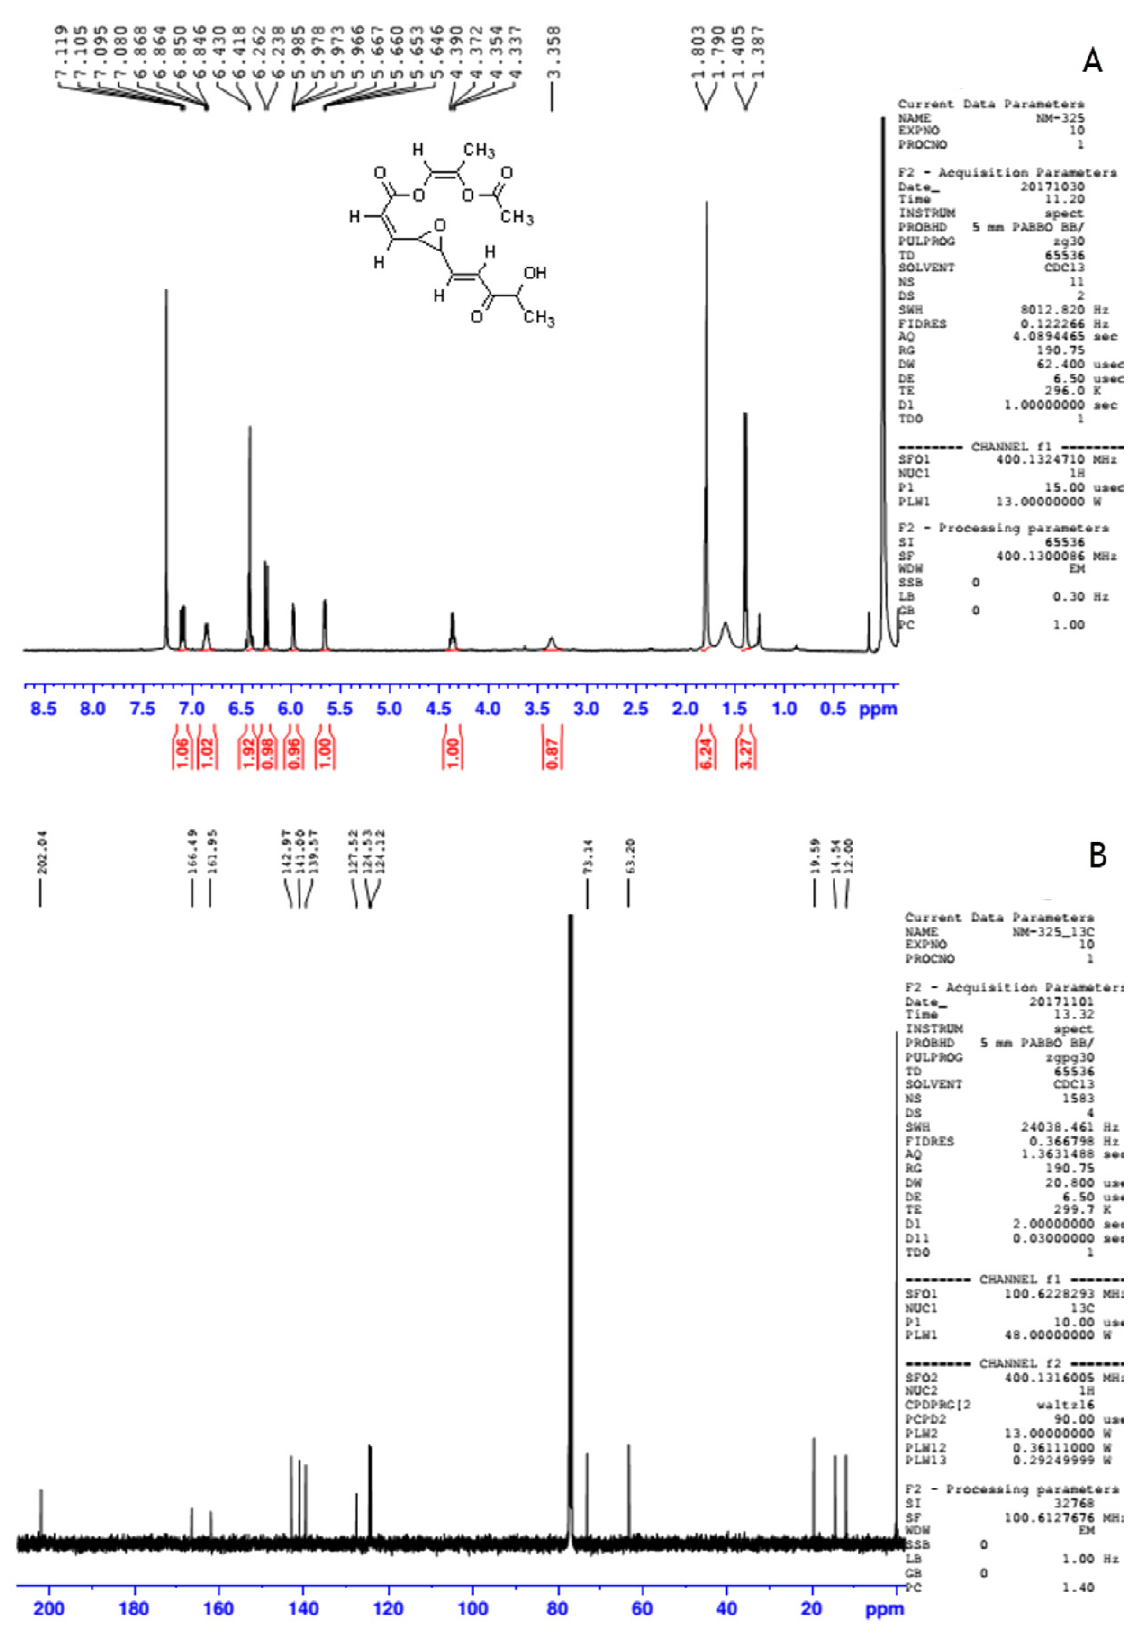
Figure 9. 1 H NMR spectra (A), 13 C NMR spectra (B) for toluene standard and compound